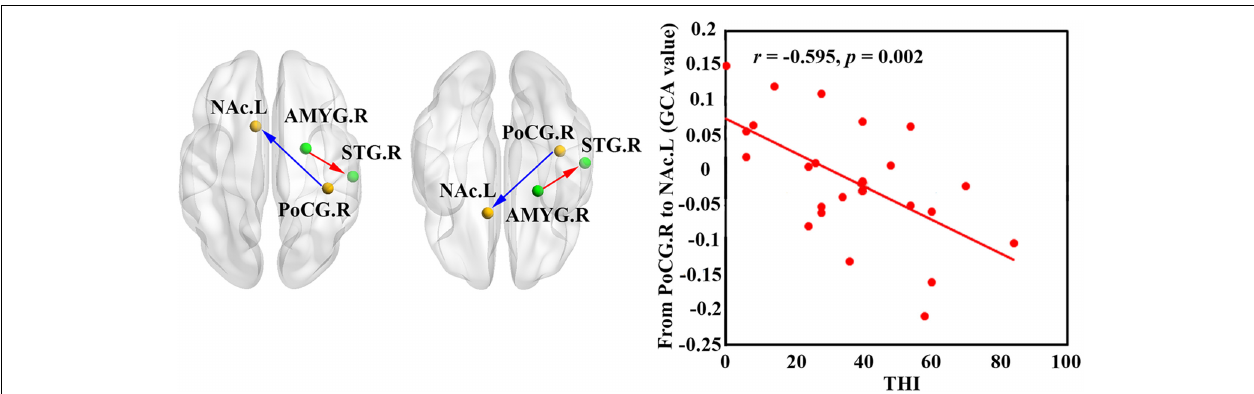
FIGURE 3 | Increased GCA value from AMYG.R to STG.R (in red) and decreased GCA value from PoCG.R to NAc.L (in blue) were found in the ISSNHL patients. The correlations between abnormal GCA value and THI in the ISSNHL patients. The red dots represent each ISSNHL patient. FC, functional connectivity; GCA, granger causality analysis; THI, tinnitus handicap inventory; STG, superior temporal gyrus; AMYG, amygdala; NAc, nucleus accumbens; PoCG, postcentral gyrus; left hemisphere; R, right